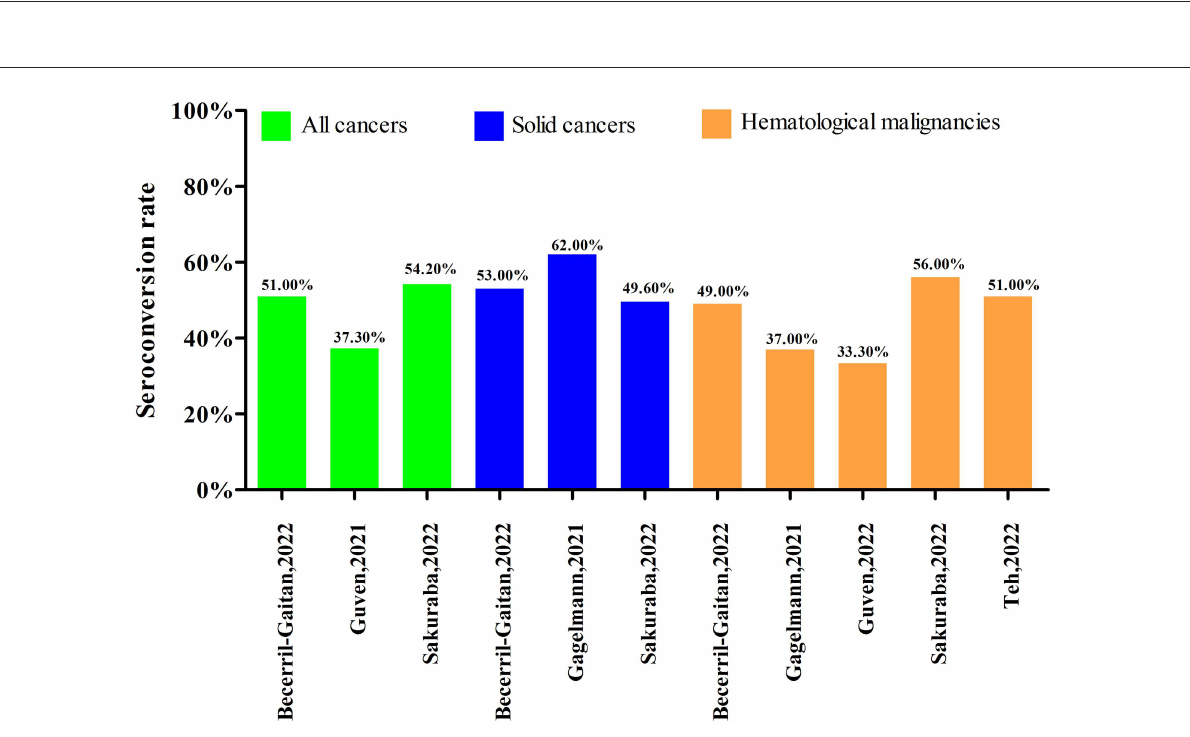
FIGURE4 Seroconversion rate after the first dose of COVID-19